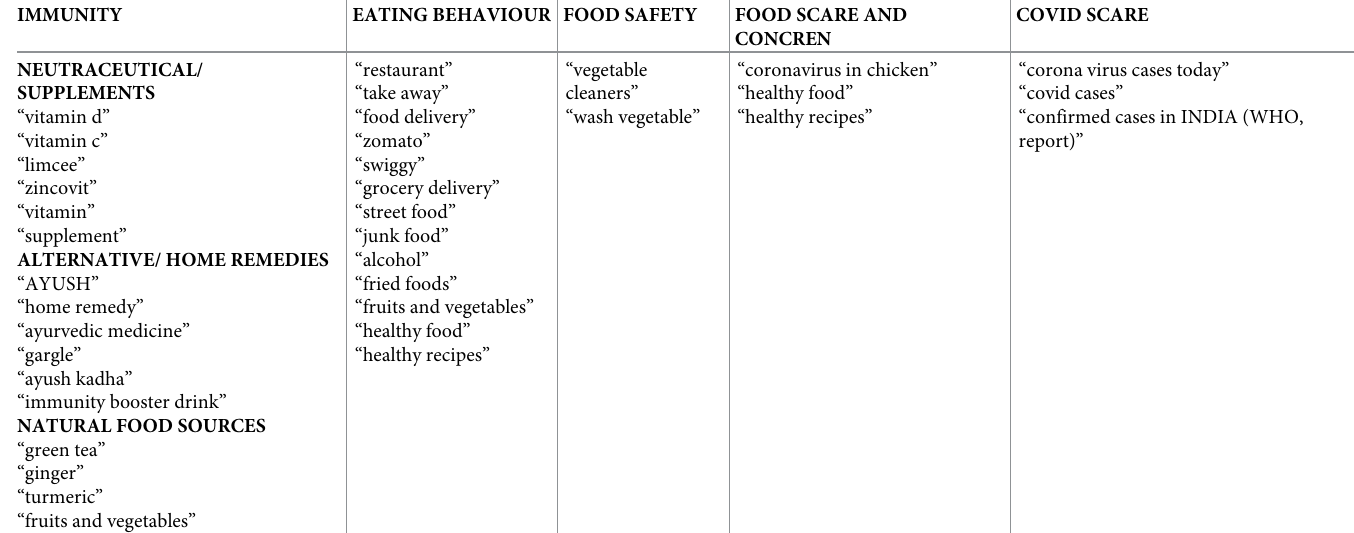
Table 1. Categorization of search terms used as key words to get relative search volumes for the period (27 th Jan 2020 to 30 th June 2021).